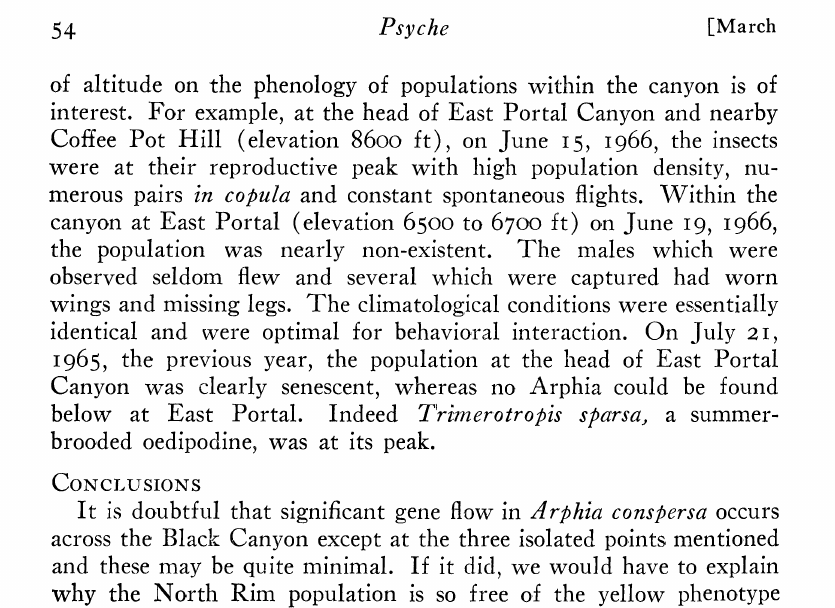
Fig. 2. (opposite page). Protocol of drphia conspe’rsa populations and locality elevations. aElevations are estimated from the following 7 1/2 minute U.S. Geo- logic Survey topographic maps" Black Ridge, Red Rock Canyon, Mt. Gunnison, Cathedral Peak, Cureeanti Needle, Grizzly Ridge, X Lazy F Ranch, Sapinero, and Little Soap